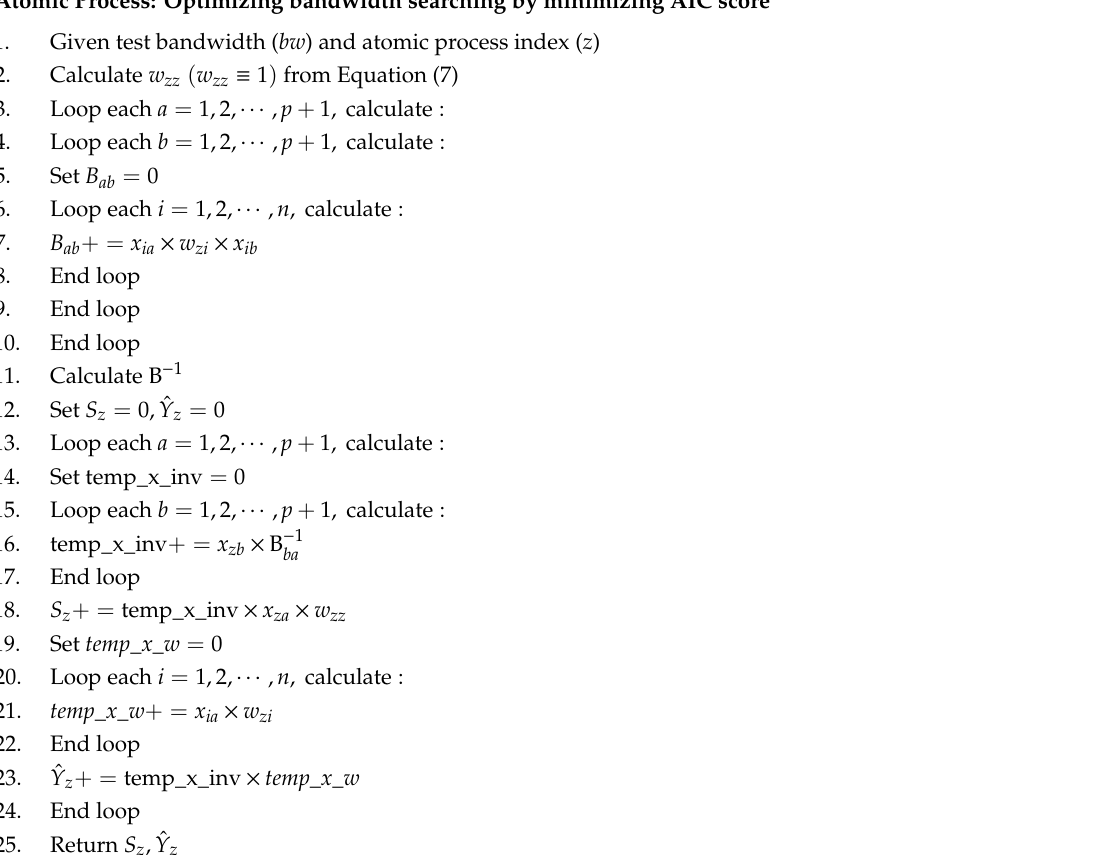
Algorithm 1 Atomic Process—The Minimum Unit of